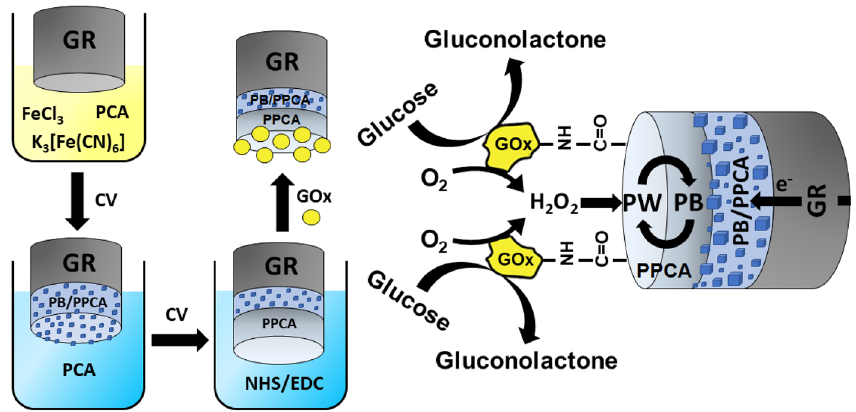
Figure 1. Scheme demonstrating fabrication and operation of the GR/PB-PPCA/PPCA–GOx